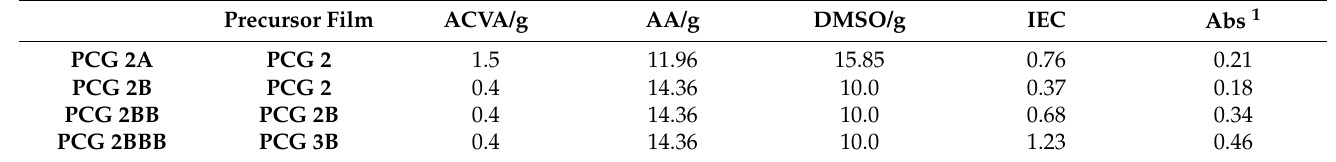
Table 2. Molar ratios of EGDMA crosslinked hydrogel film mixtures.